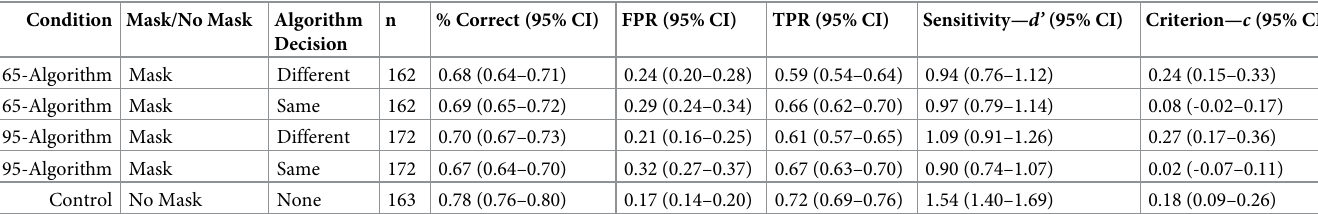
Table 2. Face matching performance as a function of survey condition for Study 2 (threshold =